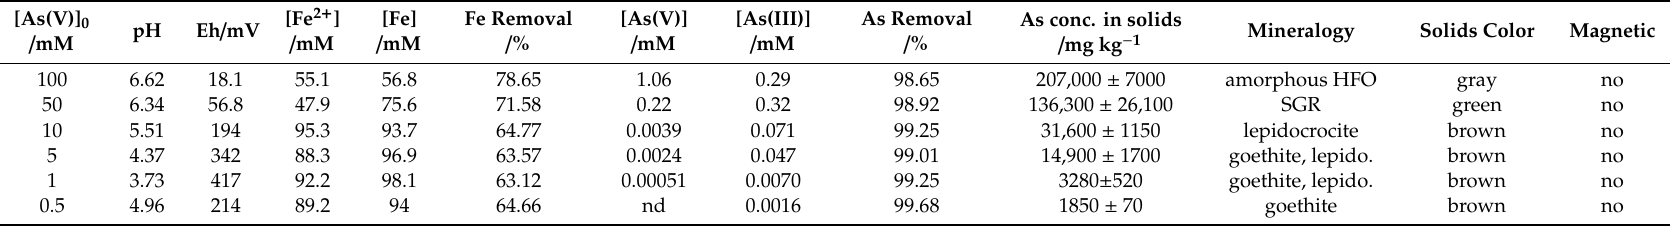
Table 2. Coprecipitation and oxidation of As(III) with Fe(II) and Fe(III) in sulfate solutions (initial [Fe] 0 = 266 mM, nd = non-detect, HFO = hydrous ferric oxide). [As(V)] 0 /